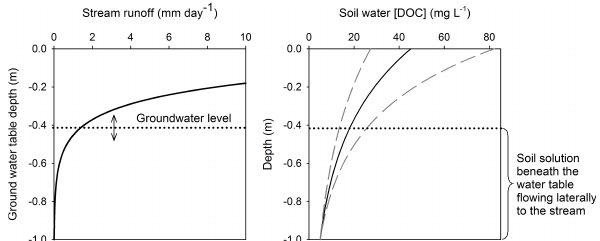
Fig. 2. Schematic view of RIM, modified from Seibert et al. (2009). The left panel shows the relationship between stream runoff and groundwater level. The right panel shows the shape of the soil water DOC concentration profile, grey dashed lines indicate the variation in f-factor (the shape of the profile) in